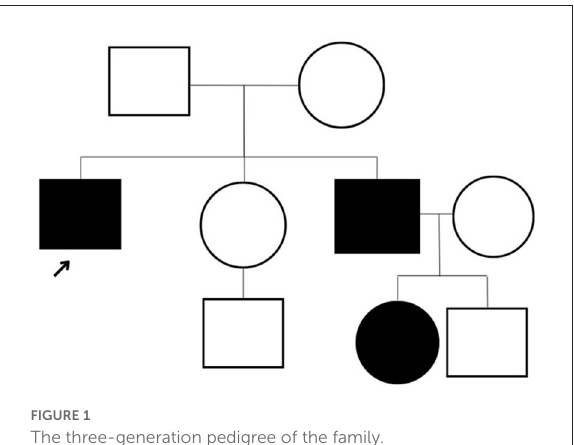
FIGURE1 The three-generation pedigree of the family.